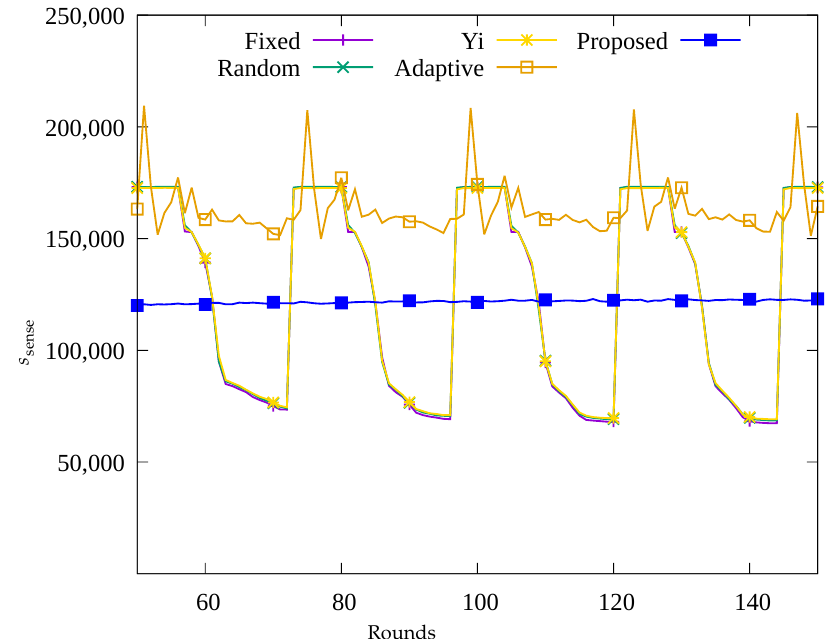
Figure 6. Comparison of the amount of data sensed over